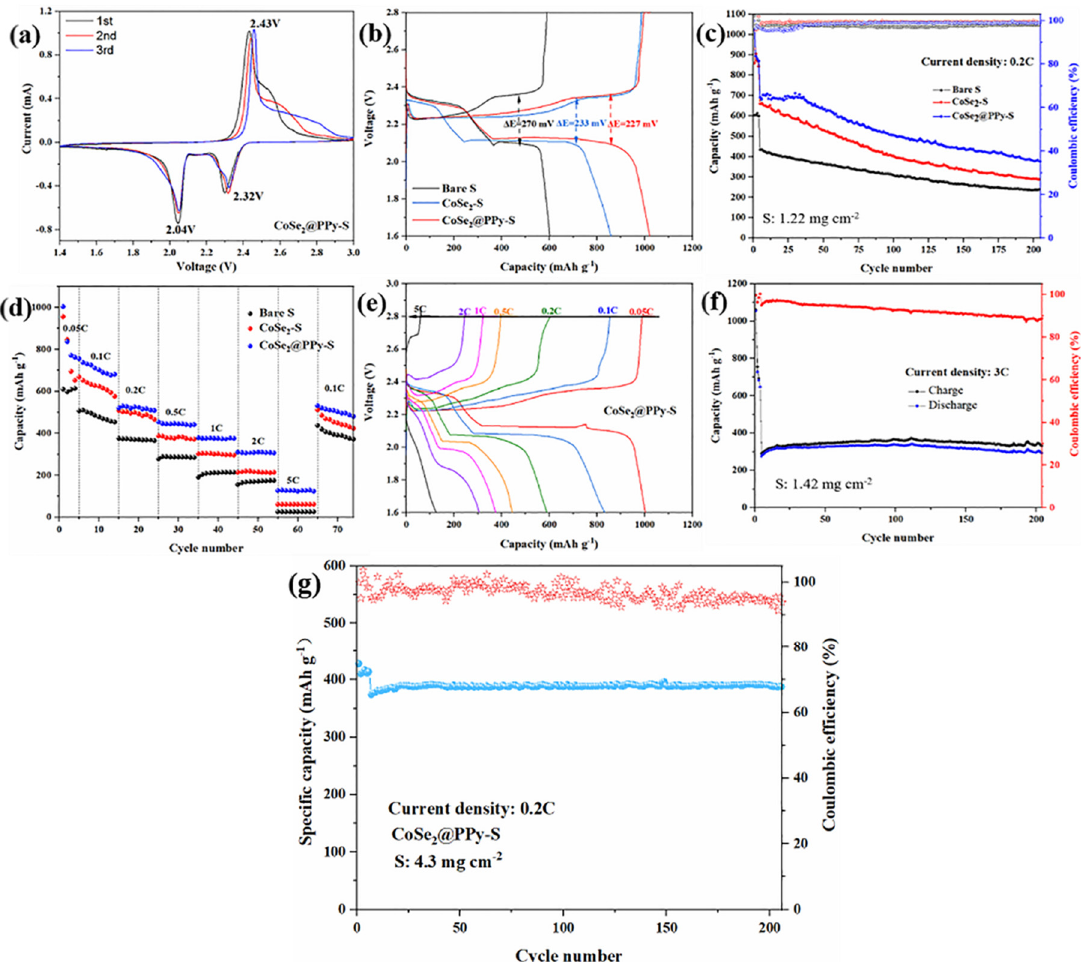
Figure 6. ( a ) CV curves of CoSe 2 @PPy-S composite at 0.1 mV s − 1 . ( b ) The comparison of dis- charge/charge curves of bare sulfur , CoSe 2 -S, and CoSe 2 @PPy-S cathodes. ( c ) Cyclic properties of bare sulfur, CoSe 2 -S, and CoSe 2 @PPy-S composites at 0.2 C after three cycles of activation at 0.05